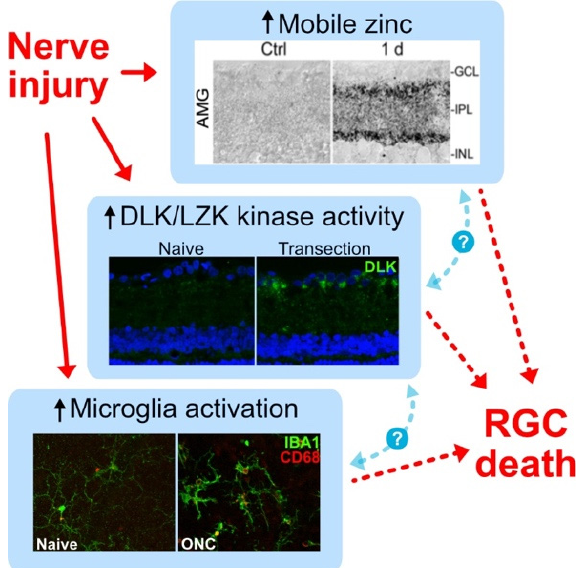
Figure 5. Injury-induced pathways contributing to RGC death after optic nerve injury. Encircled question marks (?) indicate as yet unknown relationships. Up arrows indicate increases.